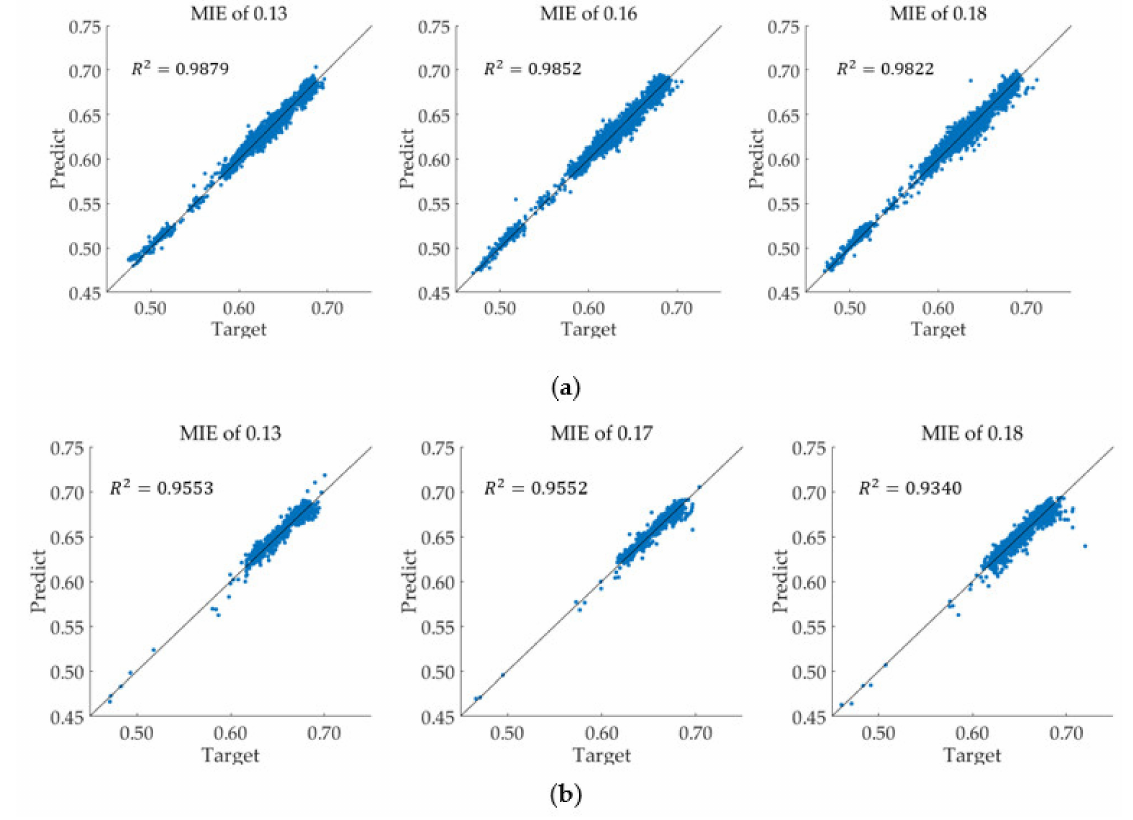
Figure 12. Estimation accuracy of different MIE: ( a ) R1; ( b )